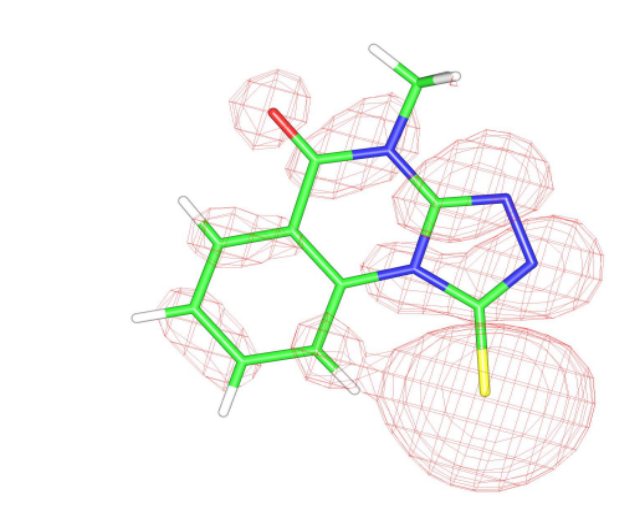
Figure1b . Graphical representation of HOMO interactions of the anion form of 1